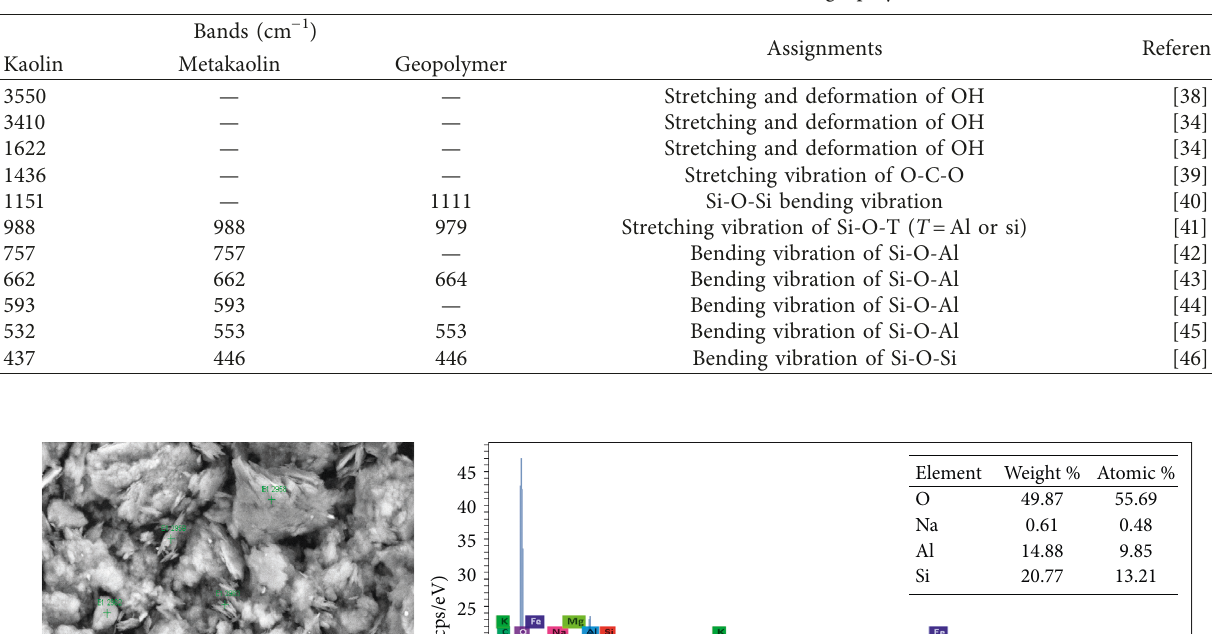
Table 4: FTIR bands (cm − 1 ) of kaolin, metakaolin, and geopolymer.